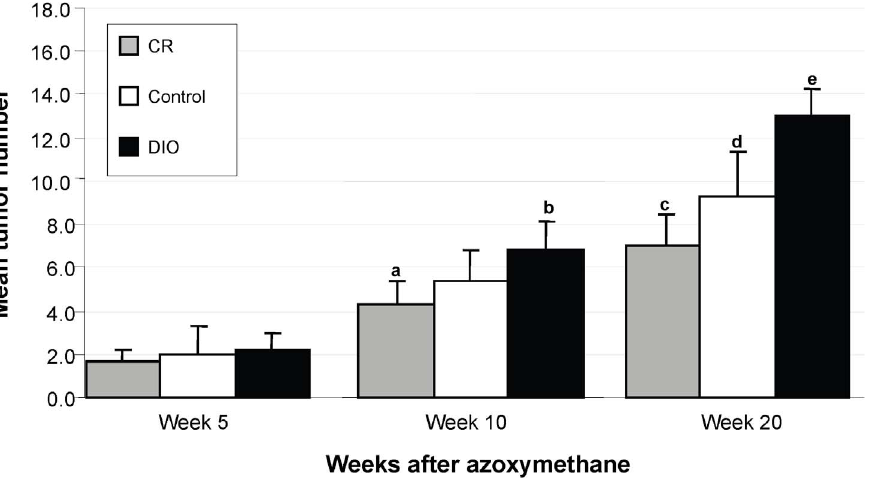
Figure 3. Tumor multiplicity among CR, control, and DIO mice. The total number of tumors was counted along the entire length of the colon after methylene blue staining. Bars represent the average number of tumors per colon in all three dietary groups (n=12 at 5 weeks, n=12 at 10 weeks, n=20 at 20 weeks). Five weeks, one-way ANOVA, p=0.63. Ten weeks, one-way ANOVA, p=0.01. Twenty weeks, one-way ANOVA, p=0.0001. a and b represent dietary treatments that are significantly different from one another (p=0.009) as determined by Bonferroni test. c , d , and e represent dietary treatments that are significantly different from one another (p , 0.05) as determined by Bonferroni test.